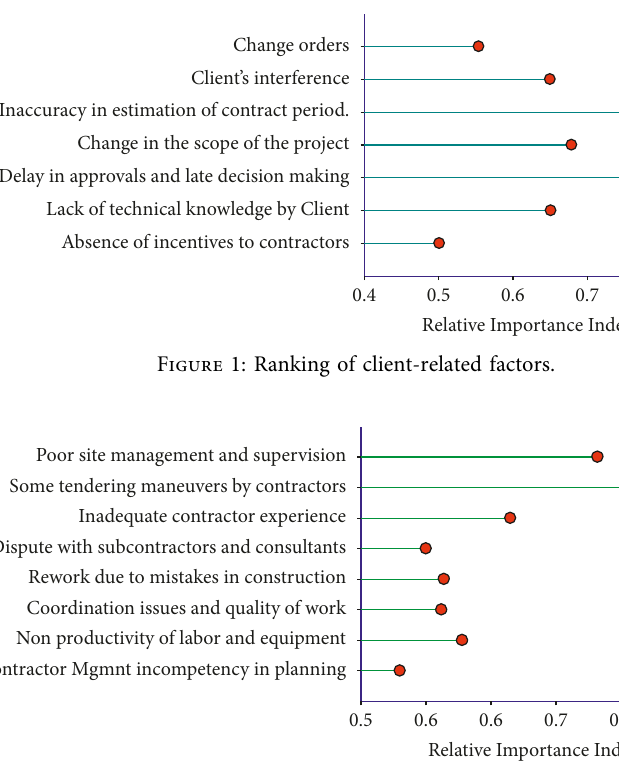
Figure 2: Ranking of contractor-related factors.